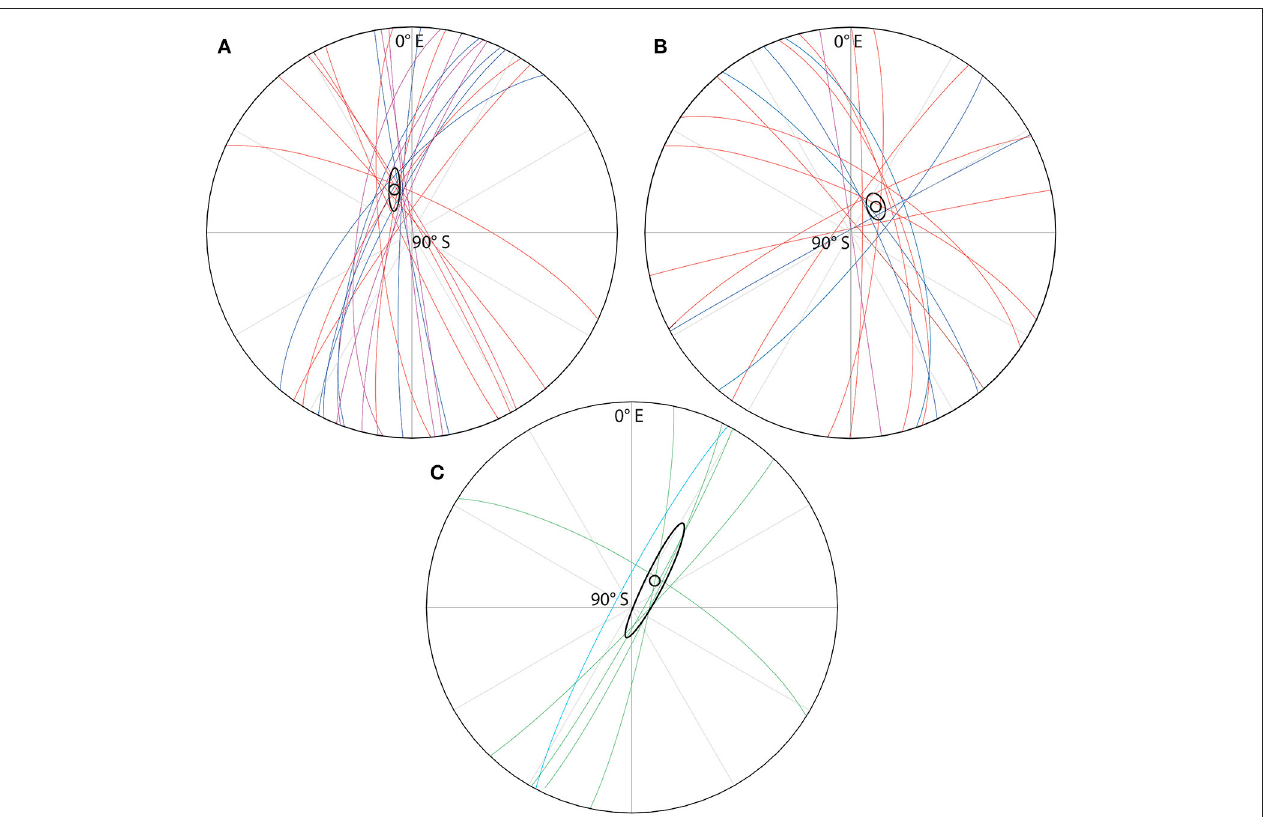
FIGURE 10 | Great circle analysis of VGP elongations. Stereonet projections of great circle-fits through the VGPs of the rock formations studied. The South pole is in the center and the prime meridian is vertical through the plots. Blue, red, purple, light blue and green data are for Carboniferous (and intruding sills), Permian, Triassic, Jurassic, and Cretaceous data. Intersections of great circles and bootstrap 95% confidence ellipses are black symbols. (A) “Late Cretaceous” distribution; (B) “X” distribution; (C) “JK-Sills” distribution. See text for